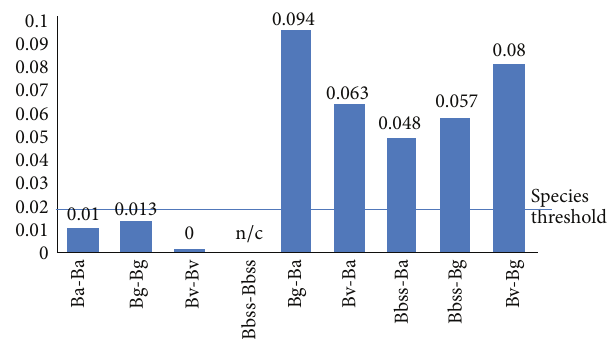
Figure 3: Mean pairwise difference within and between Borrelia genospecies. The line indicates species threshold (0.017) as defined by Margos et al.